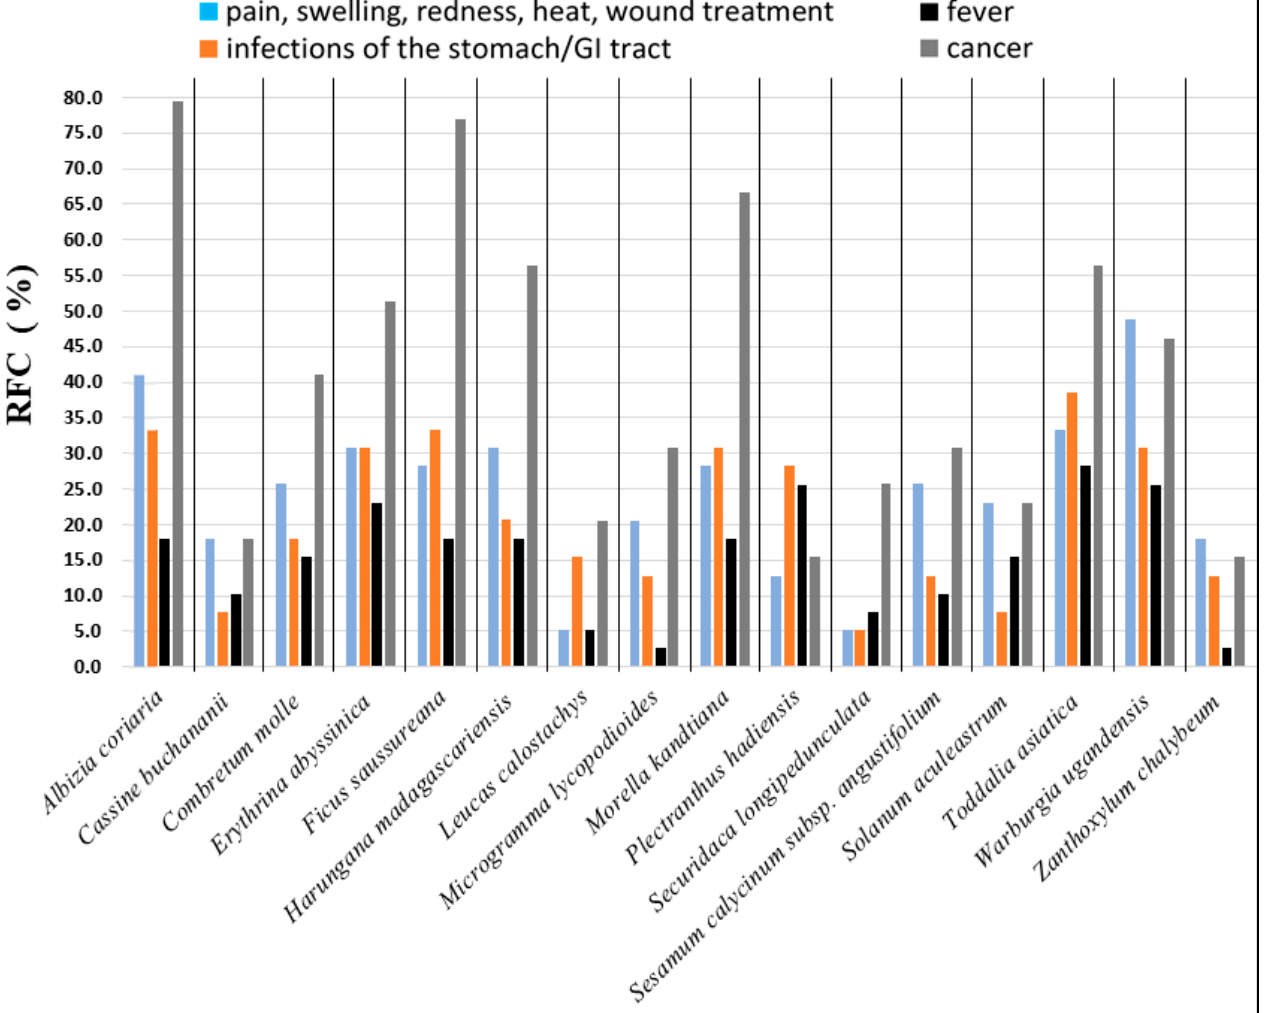
Figure 1. Ethnopharmacological information, describing the traditional use of 16 medicinal plants from the Greater Mpigi region in Uganda (with emphasis on the treatment of cardinal signs of acute inflammation, cancer, and stomach and gastrointestinal (GI) tract infections). The histogram shows the relative frequencies of citation (RFCs) in %, a field assessment index that was calculated from an ethnobotanical survey of 39 traditional healers. The RFC describes the use of plants to treat a specific medical condition relative to the total number of interviewees in the study, assessing the significance of a plant species in the local traditional medicine system (y-axis). This ethnobotanical index can vary from 0% (no survey participant uses this plant in treatment of a specific medical condition) to 100% (all survey participants use this plant in treatment of a specific medical condition) [5].